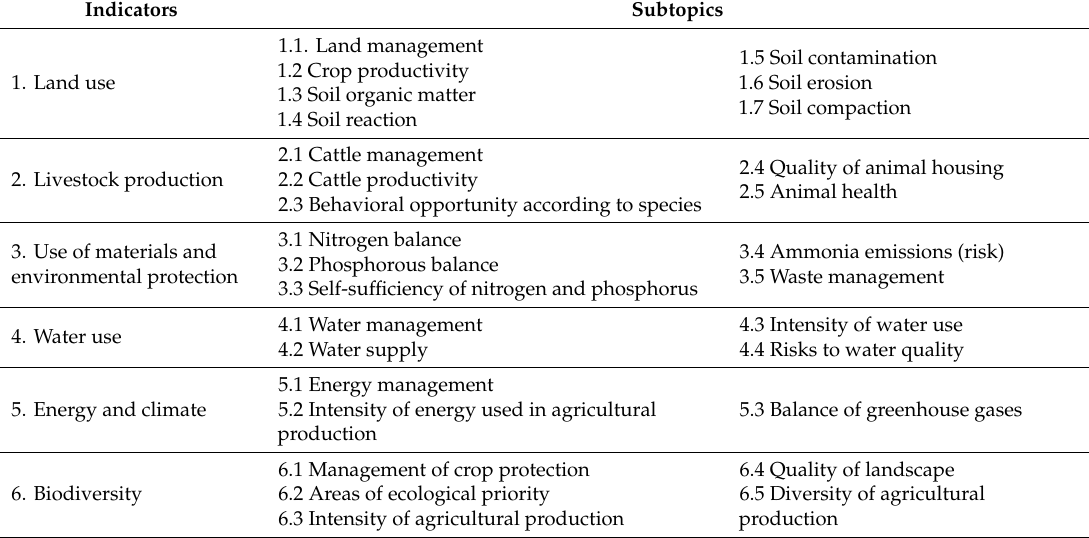
Table 2. Indicators and parameters used in this study based on response-inducing sustainability evaluation (RISE) 3.0